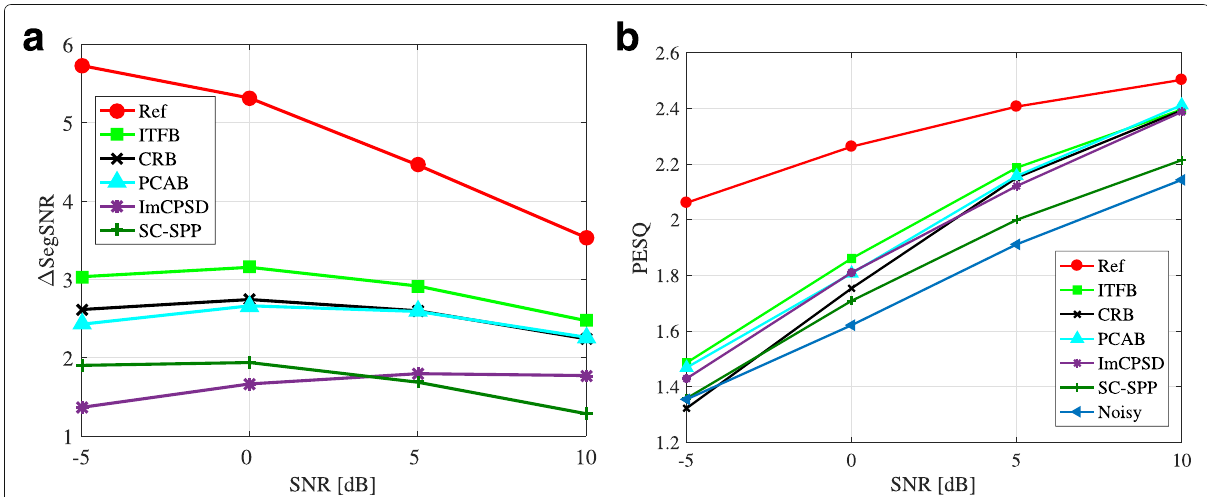
Fig. 8 Speech enhancement comparison in terms of a (cid:13) SegSNR and b PESQ for different algorithms averaged over all noise types ( θ = − 90 ◦ )